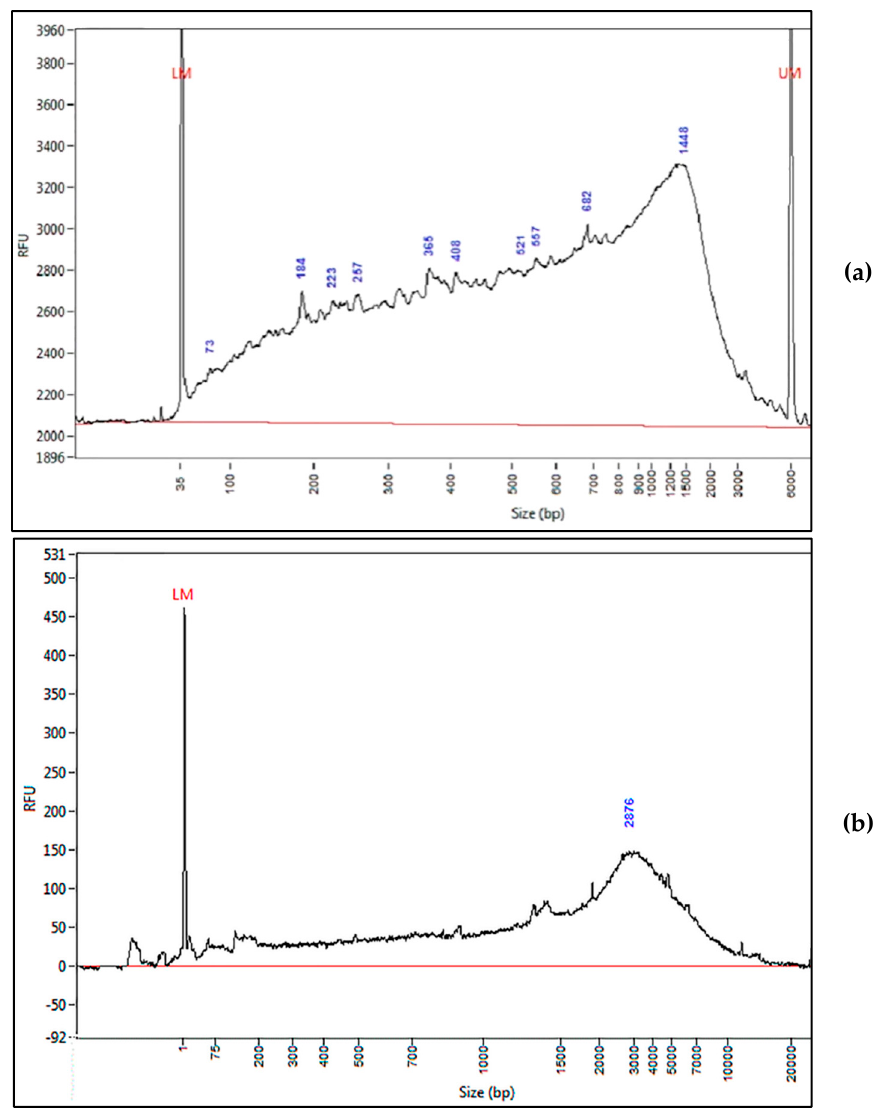
Figure 3. In vitro digestions of E. dunnii genomic DNA. Fragment Analyzer system runs. ( a ) SphI-MboI. ( b ) PstI-MspI .